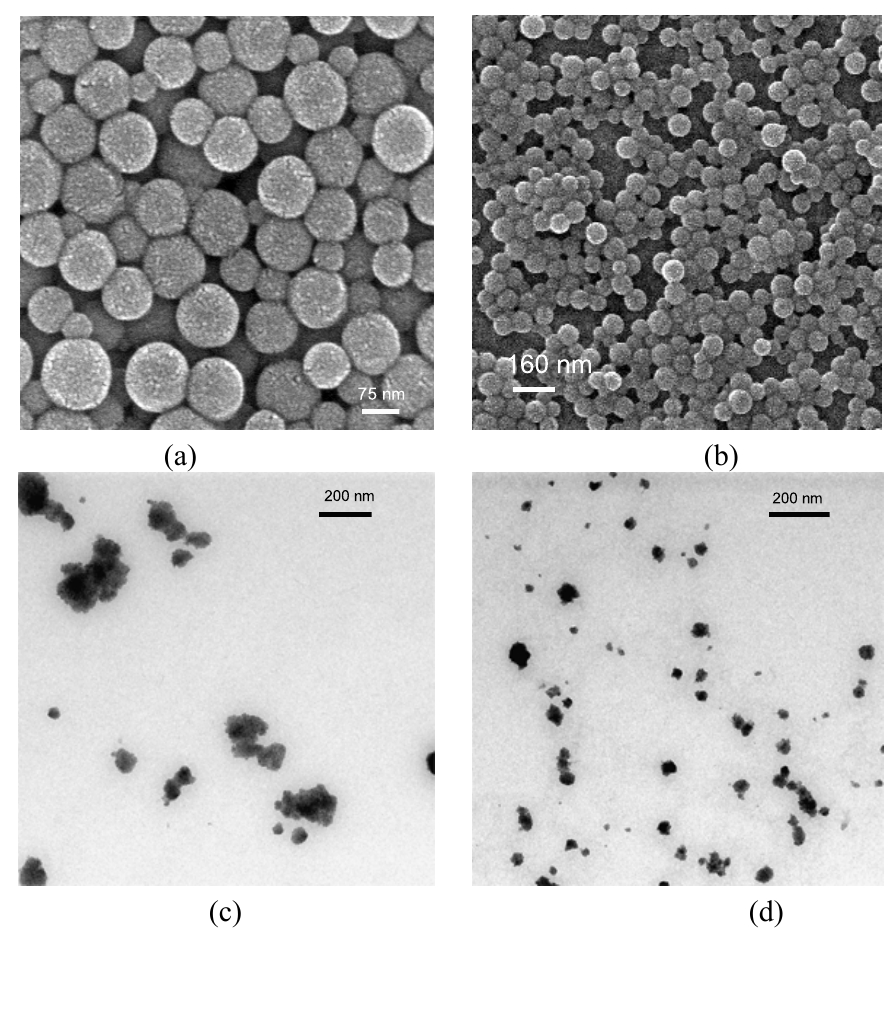
Figure 2. (a) Crosslinked polystyrene latex particles generated by the use of surfactant, (b) particles of Figure 2a surface modified with ATRP initiator and (c) and (d) are the particles of Figure 2b after grafting with poly( N -isopropylacrylamide)